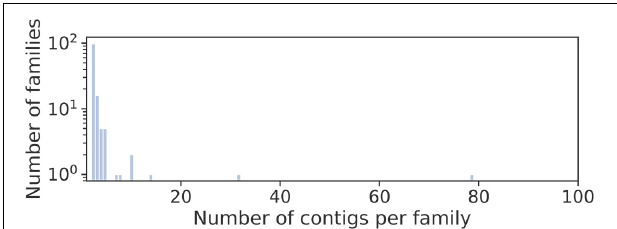
FIGURE 4 | Distribution of families of long circular contigs in Dicyema sp. vs. the number of members per family. To detect families, blastn searches of all long ( > 500 bp) circular contigs against themselves were conducted. The graph elements are contigs, and the edge weight is hits E -value. All edges with the weight greater than 1e-10 were deleted, and contigs in one connected component are considered a